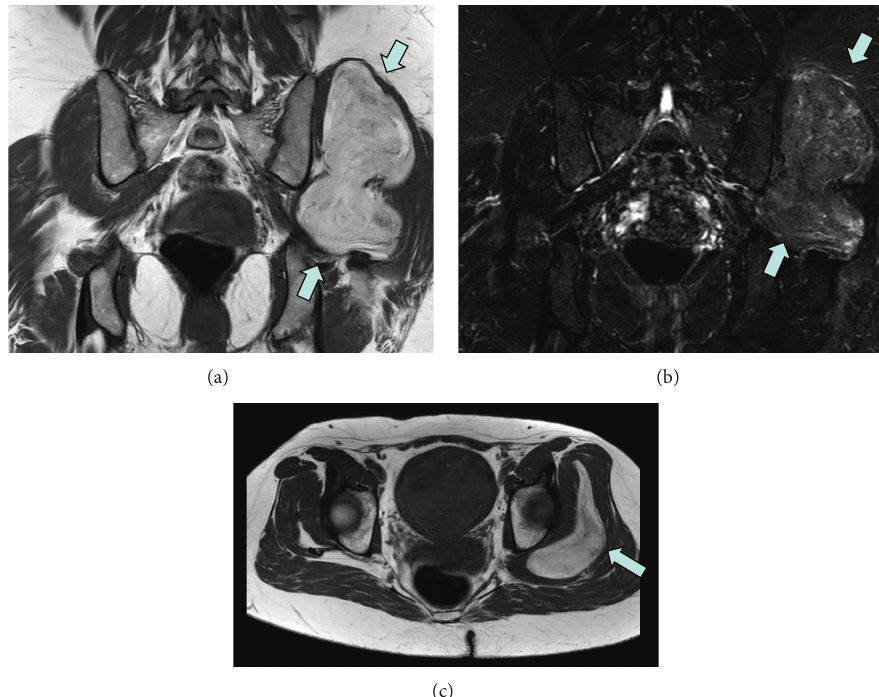
Figure 3: (a) Coronal T1, (b) coronal STIR, and (c) axial T1 MRI images demonstrate a lobulated mass of complex fat attenuation arising from the left gluteus medius muscle, outlined by blue arrows.